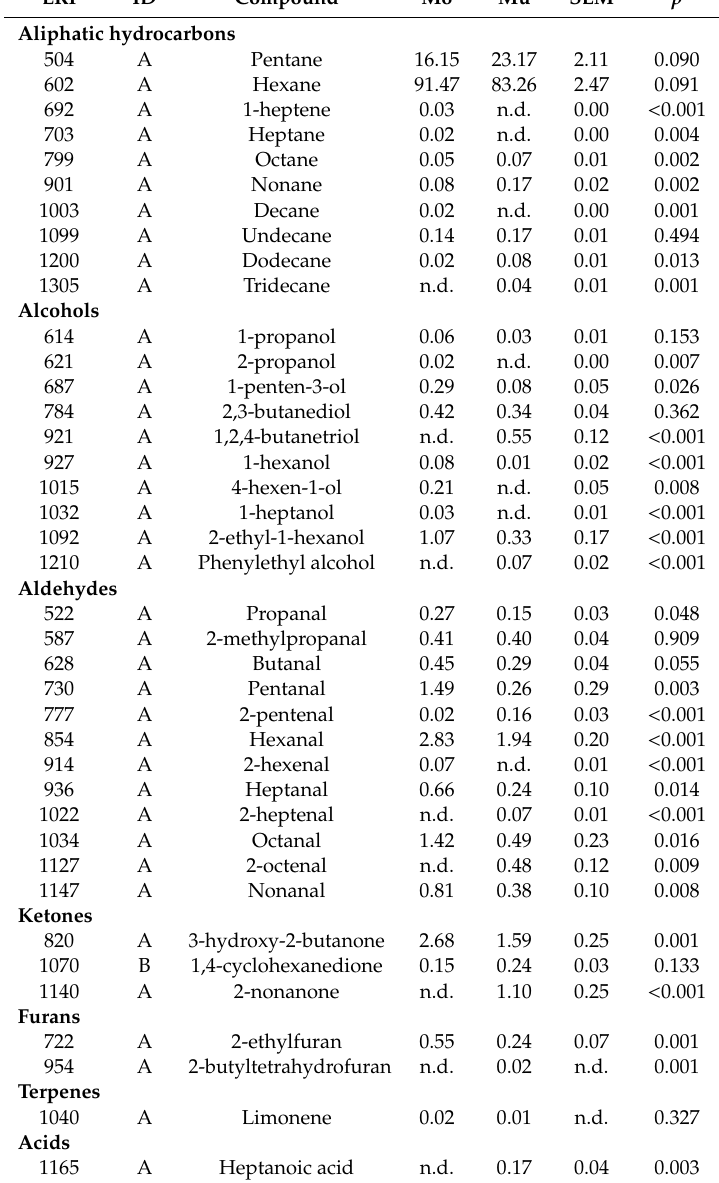
Table 1. Volatile compounds from monolayered (Mo) and multilayered (Mu) fish oil microcapsules. Values are expressed as peak area × 10 6